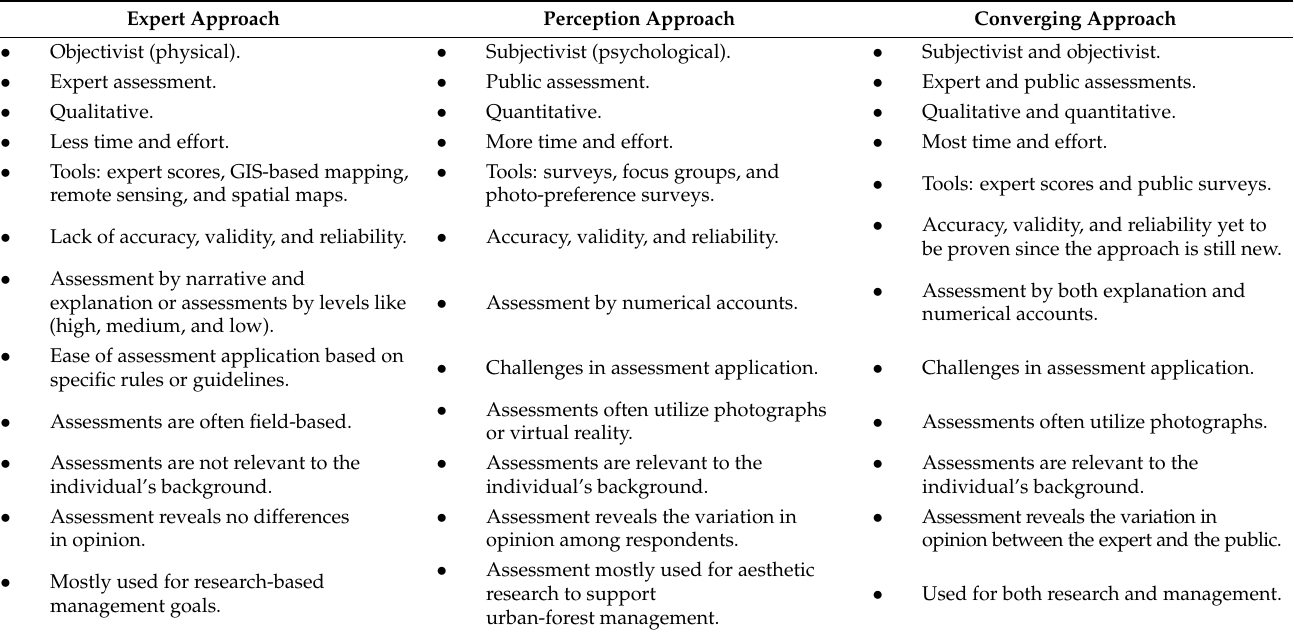
Table 3. Summary of the approaches for assessing urban-forest